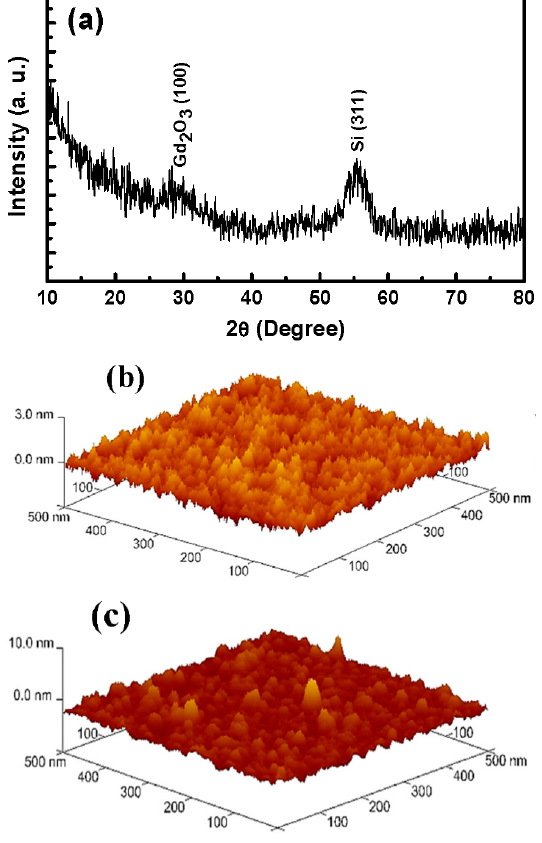
Figure 3. XRD and AFM characterization. ( a ) XRD pattern of the GdO x /Si stack which represents the crystalline GdO x film. Three-dimensional (3D) AFM images of ( b ) SiO 2 /Si and ( c ) GdO x /Si stacks with a scan area of 500 × 500 nm 2 are shown.